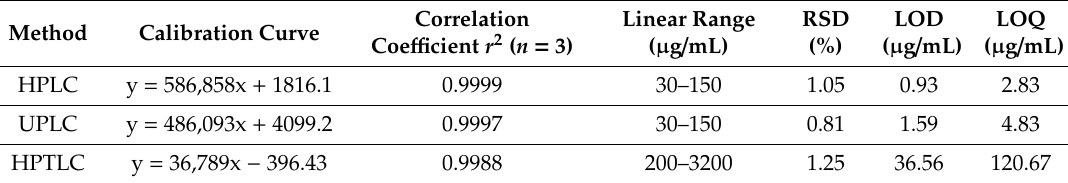
Figure 5. Results obtained from HPTLC studies: ( A ) HPTLC plates; ( B ) typical chromatogram obtained from each trace; ( C ) calibration curve for quantitative measuring of component (1-standard of hederacoside C; 2, 4, 5 ivy leaf extracts 9-syrup; 3, 6, 8-capsules; 7-capsule placebo; 10-syrup placebo), yellow frame shows the position of hederacoside C spots on the plate. Table 2. Obtained results from studying linearity, LOD and LOQ.